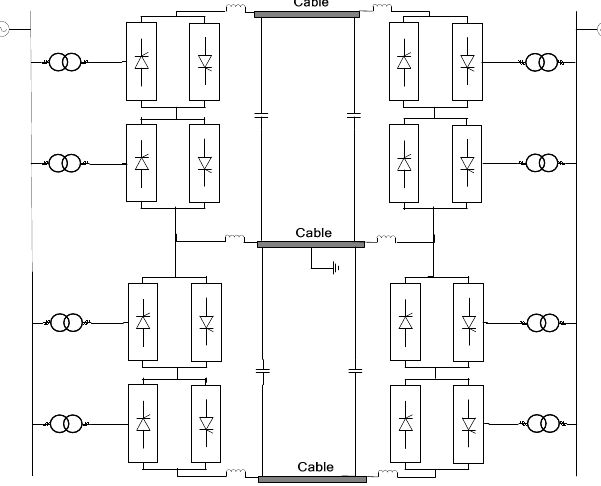
Figure 6. Configuration of single ‐ phase low frequency ac transmission system (LFAC).